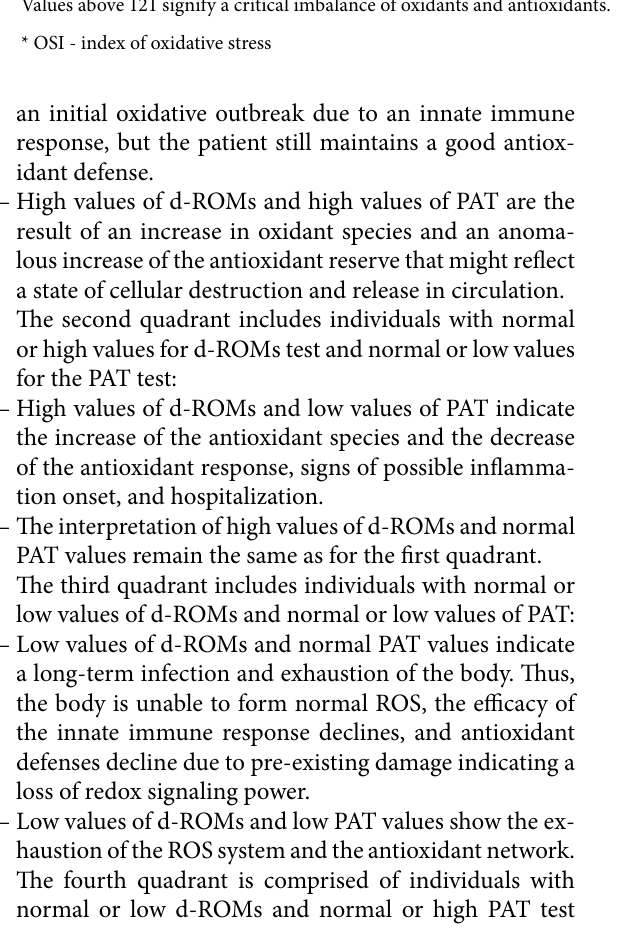
Figure 1: Coordinate system representing OSI and four different quadrants for interpretation. OSI values less than 40 represent normal levels. Values between 41-65 are borderline alert and normal. Values ranging from 66-120 signify a concerning imbalance between oxidants and antioxidants. Values above 121 signify a critical imbalance of oxidants and